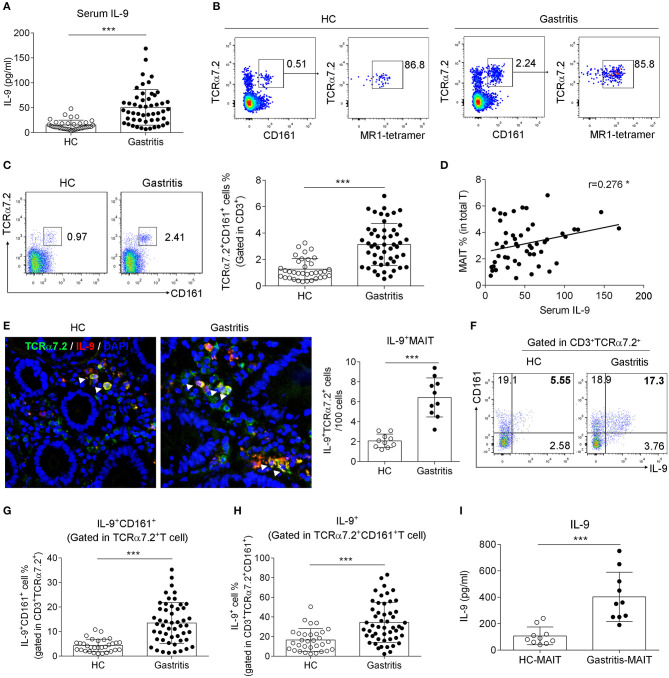
Increased IL-9-producing MAIT cells were found in the gastric mucosa of H. pylori-positive patients. Serum and the biopsy samples from gastric mucosa of H. pylori-positive patients (n = 51) and healthy controls (n = 35) were collected, respectively. (A) Serum IL-9 level was measured by ELISA. (B) The percentage of MR1-tetramer+ cells was determined in gastric lymphocytes gated on TCRa7.2+ CD161+ cells. (C) The percentage of MAIT cells in the gastric mucosa was determined by flow cytometry. (D) The correlation between the percentage of MAIT cells in the mucosa and serum IL-9 concentration was analyzed (n = 51). (E) Immunofluorescence was performed to evaluate the co-localization of MAIT cells (Green, indicated by TCRα7.2) with IL-9 (Red) (n = 10). Nucleus was stained with DAPI (Blue). Percentage of IL-9+ CD161+ cells (gated in TCRα7.2+ T cells) (F,G) and IL-9+ MAIT cells (gated in TCRα7.2+ CD161+ T cells) (H) were assessed by flow cytometry. (I) Sorted MAIT cells were stimulated by anti-CD3 and CD28 Abs for 12 h. IL-9 concentration in the culture supernatant of MAIT cells was tested by ELISA (n = 10). Data represented the mean ± S.D from at least three independent experiments. Unpaired Student's t-test was used to compare HC and gastritis groups. *P < 0.05; ***P < 0.001.